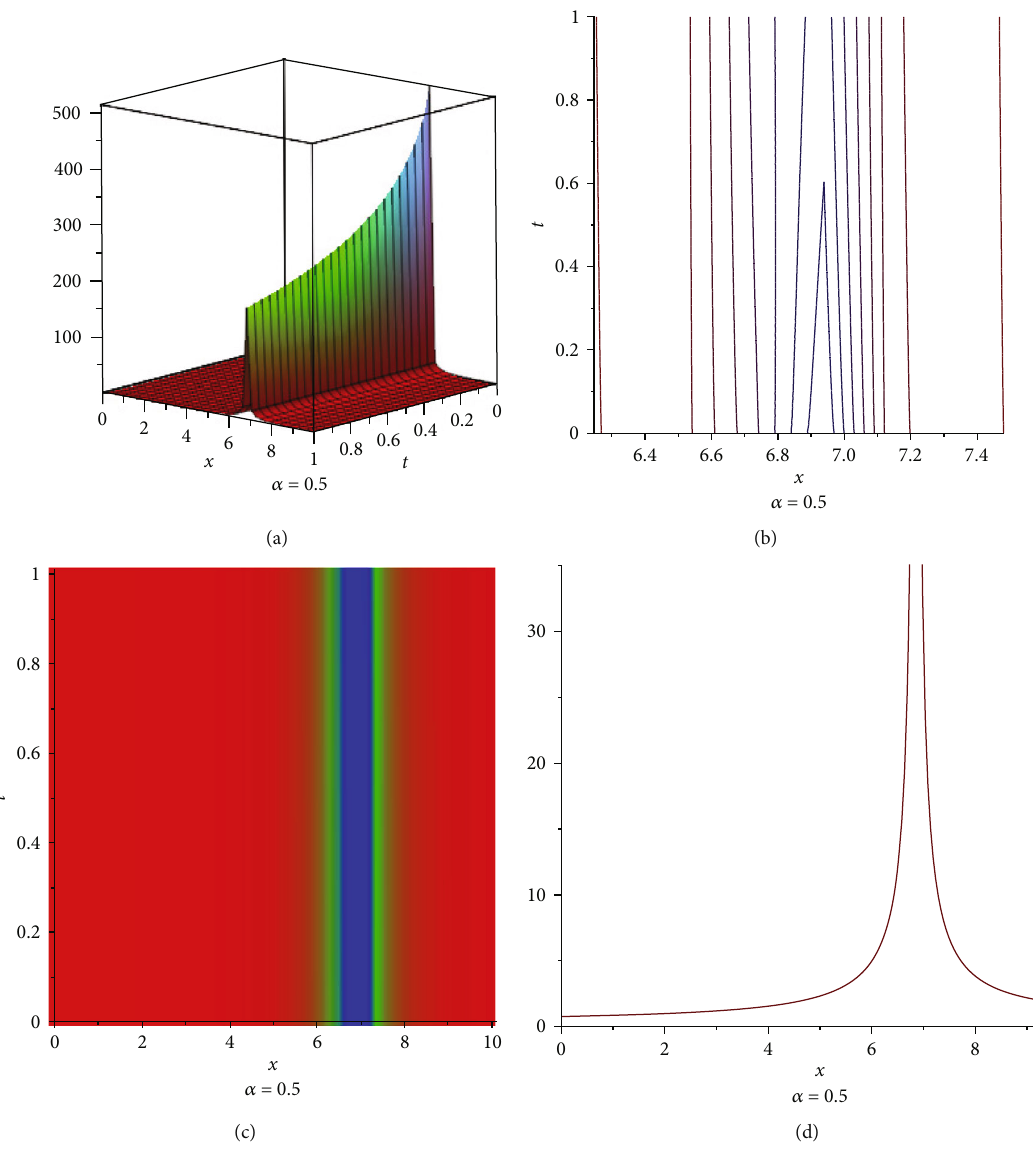
= 0 : 3, δ = δ = d = d = 0 : 1, 1 2 3 1 2